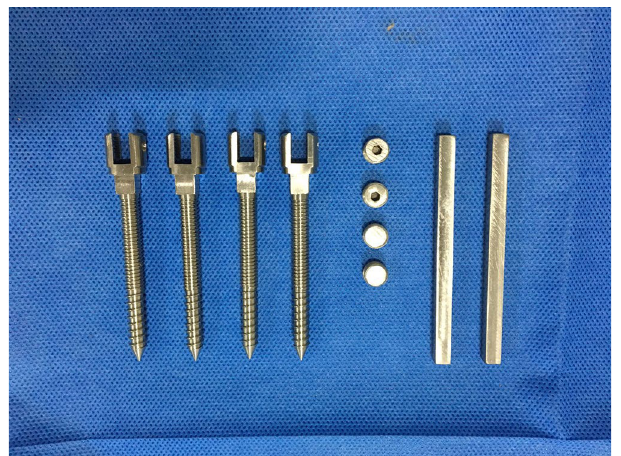
Figure 11. The special designed screws (diameter = 6.5 mm) and connecting rods (side length = 5.5 mm) for attaching strain gauges.